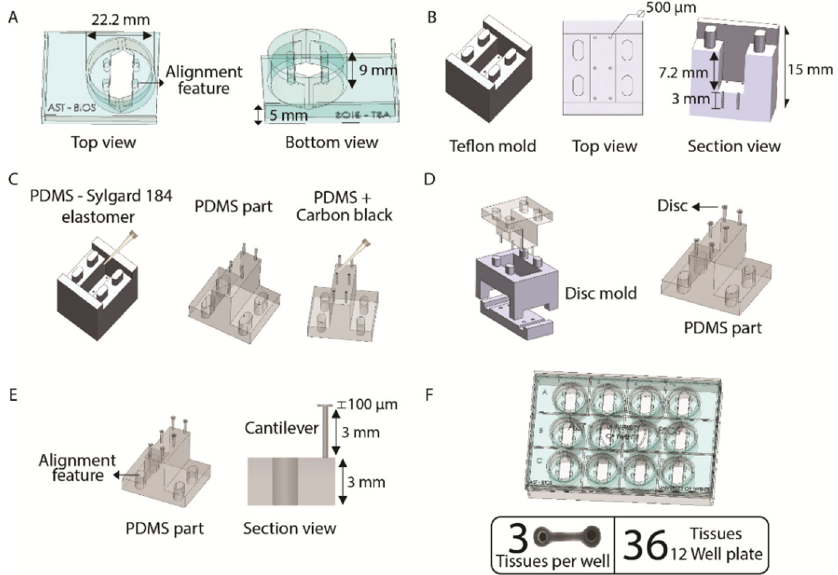
Figure 2. Fabrication of the platform. ( A ) Dimensions of a holder of PMMA in a top and bottom view. ( B ) Schematic of negative Teflon mold of PDMS-part. ( C ) PDMS-part fabrication process. ( D ) Schematic of disc fabrication. ( E ) Illustration of the PDMS mold and dimension of the cantilever. ( F ) EHT platform on a 12-well plate.